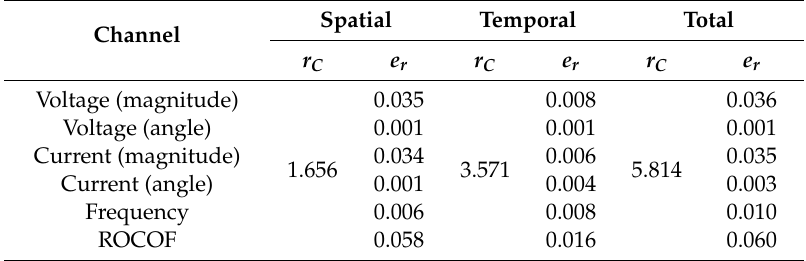
Table 7. Compression rates and reconstruction errors for di ff erent measurement